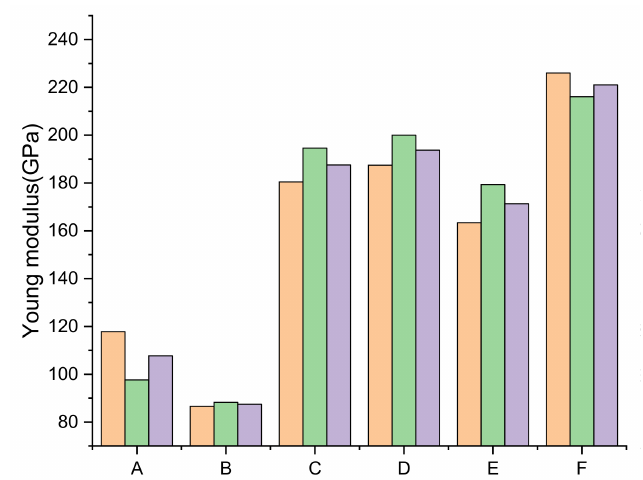
Figure 14. Distribution range of Young’s modulus value in gray area.